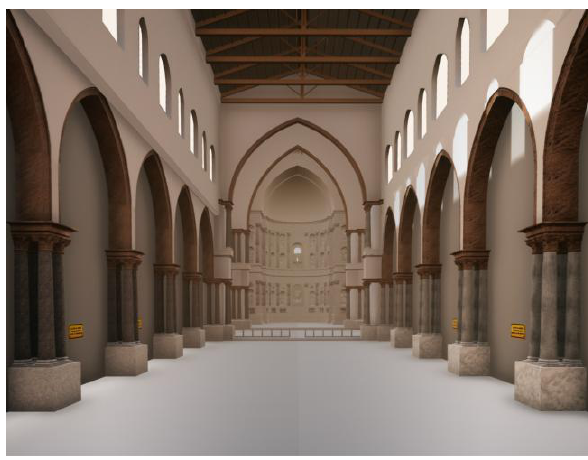
Figure 15: Perspective view of the 18th century